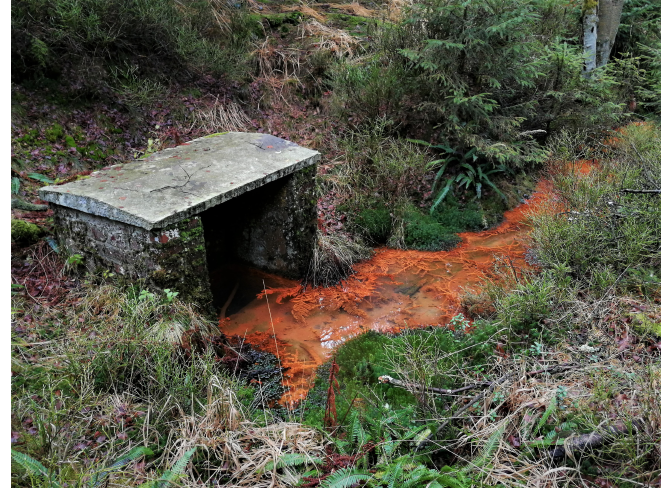
Figure 3. CO 2 -rich groundwater upflows to the surface, forming springs of naturally sparkling water. The springs present an intense orange-red colour due to the iron precipitation at the